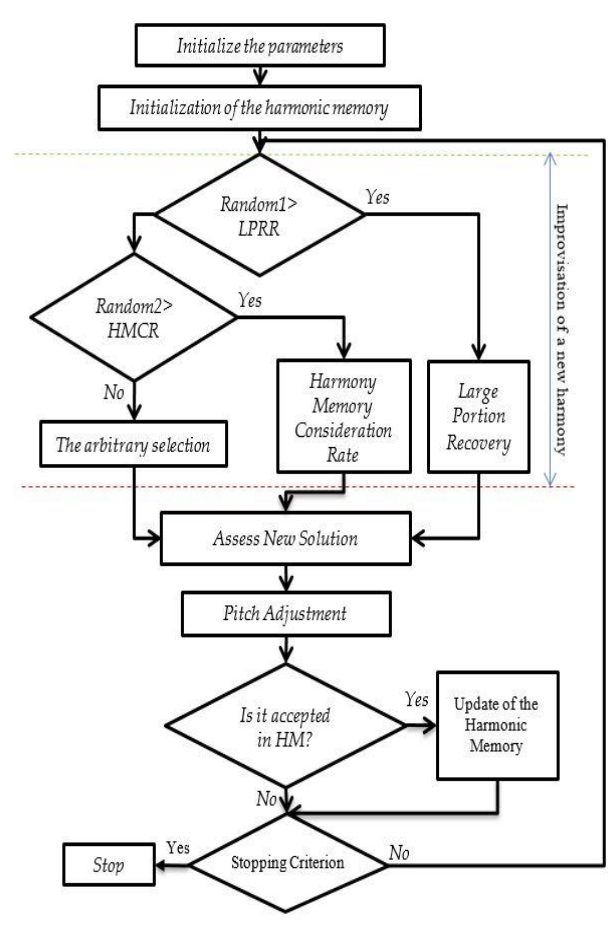
Figure 7. Modified harmony search (MHS) flowchart.